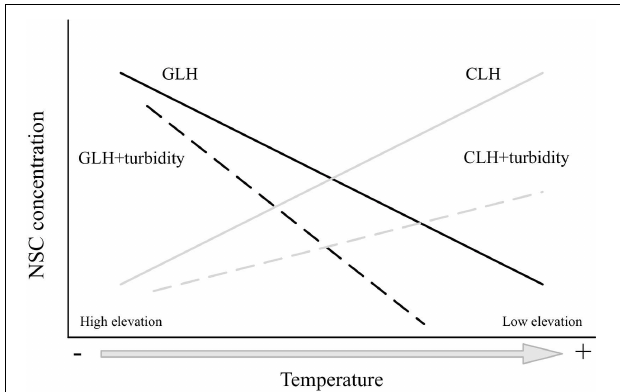
FIGURE 1 | Expected trends of non-structural carbohydrate concentrations (NSC) with elevational gradients (temperature effects) according to the growth-limitation hypothesis (GLH; black lines) and carbon-limitation hypothesis (CLH; gray lines), which considers the alternative effects of water turbidity. The effect of temperature on either the photosynthesis (CLH), or the growth (GLH) is displayed by continuous lines. The alternative impact of water turbidity is displayed by long-dashed lines. If supporting the GLH, a steeper NSC-elevation slope is predicted (black long-dashed line). In contrast, if supporting the CLH, higher NSC concentrations are anticipated to occur at lower elevations (with higher temperatures) (gray long-dashed line) (see text for further details on the